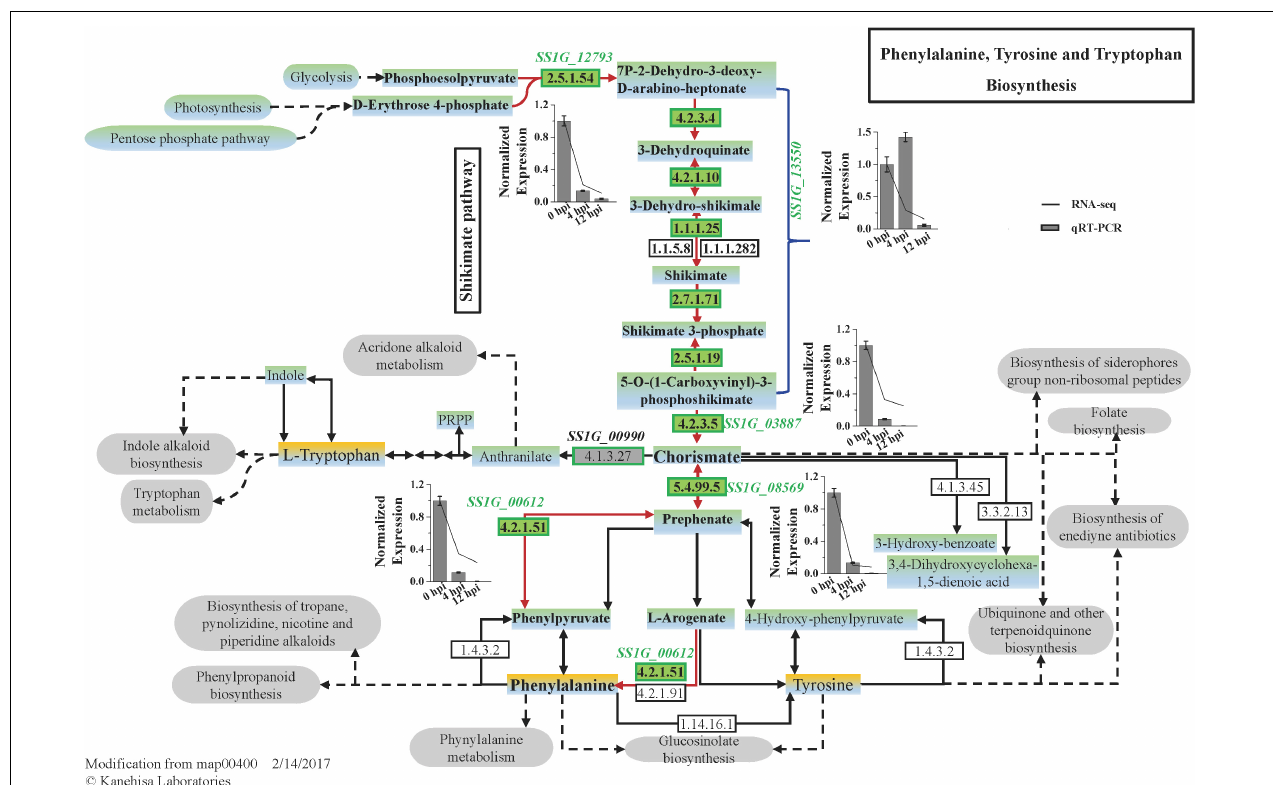
FIGURE 4 | The pathway map of Phenylalanine, Tyrosine, and Tryptophan Biosynthesis (map 00400) predicted in S. sclerotiorum and the DEGs enriched in the pathway induced by C. minitans . The italics are the genes putatively involved in the phenylalanine, tyrosine, and tryptophan biosynthesis process. The numbers in the green block are the EC (Enzyme Commission) numbers in enzyme nomenclature databasehttps://enzyme.expasy.org/ and were predicted to be encoded by genes presented near the green box. During the early interactional stages of S. sclerotiorum induced by C. minitans , the gene expression identified in the biosynthesis process was detected in the interactional transcriptome and confirmed by using qRT-PCR. In bar charts, the lines show the relative expression from RNA_seq and the bars represent the data from qRT-PCR. The gene expression of 0 hpi was set as 1 and the error bar was calculated with three replications. The KEGG pathway of map00400 was download from https://www.kegg.jp/ and the gray oval frames are predicted to be the related pathways of the phenylalanine, tyrosine, and tryptophan biosynthesis